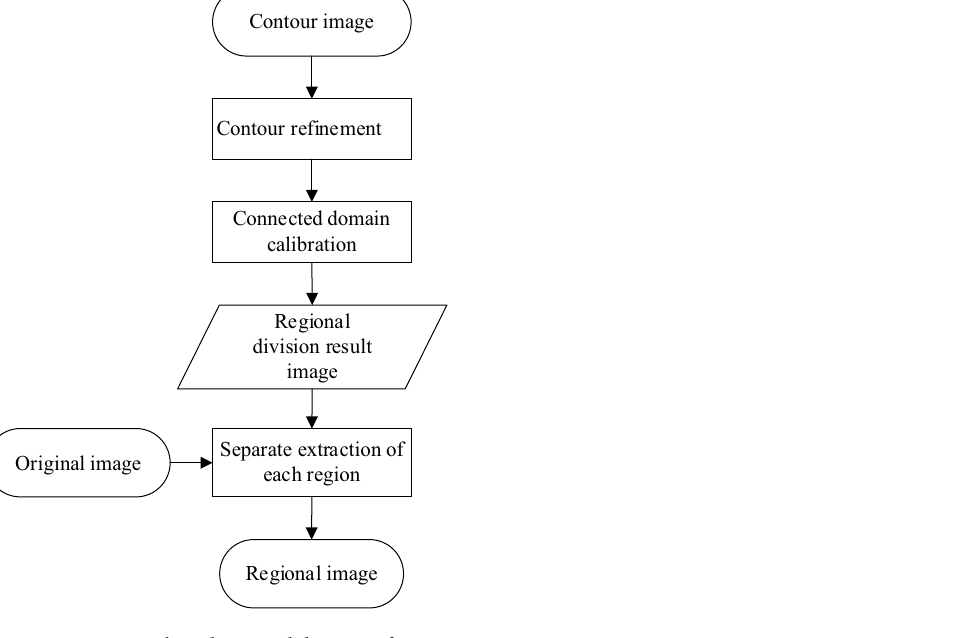
Figure 3. Contour-based regional division of an image.